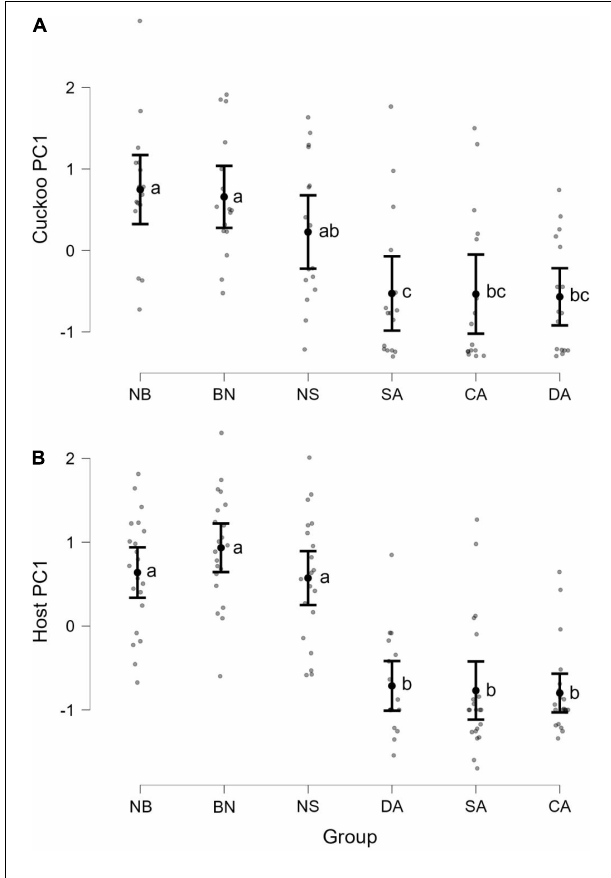
FIGURE 1 | Pairwise comparisons of principal component 1 (PC1) between different treatments of experiments used to analyze the begging behaviors of common cuckoo ( A : Cuckoo, n = 16) and oriental reed warbler ( B : Host, n = 21) nestlings. NB, normal begging; BN, background noise; NS, natural singing; DA, dove alarm; SA, sparrowhawk alarm; CA, cuckoo alarm. Values are presented as mean ± SE with different letters indicating statistically significant differences between treatments in cuckoo or host nestlings ( P < 0.05). No statistical significance of PC1 was detected between cuckoo and host nestlings within each